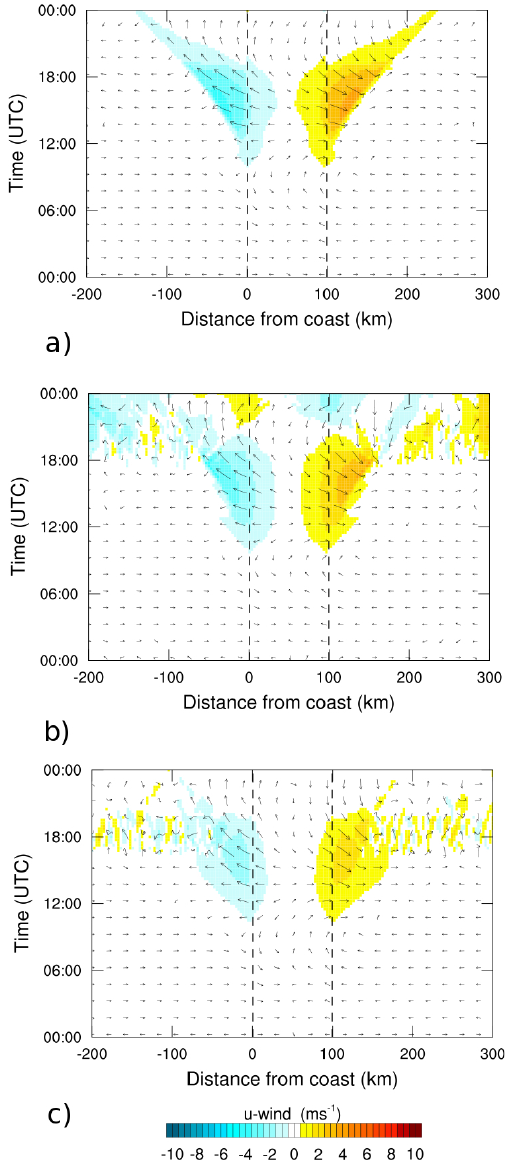
Fig. 19. Baseline windfield cases (no gradient wind) for dual-coast simulations using (a) YSU, (b) MYJ and (c) MYNN boundary layer schemes. Dashed lines represent each coastal boundary and dis- tances are expressed as seaward from the western coastline. The SST for all simulations was